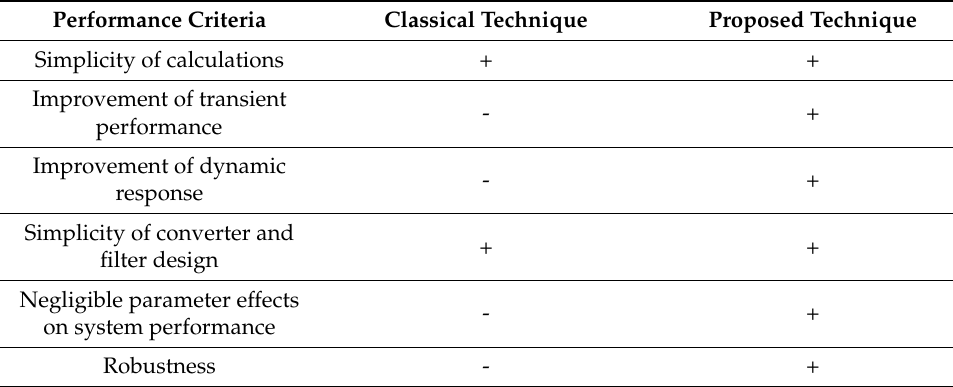
Table 3. Comparison between proposed strategy and classical method. Performance